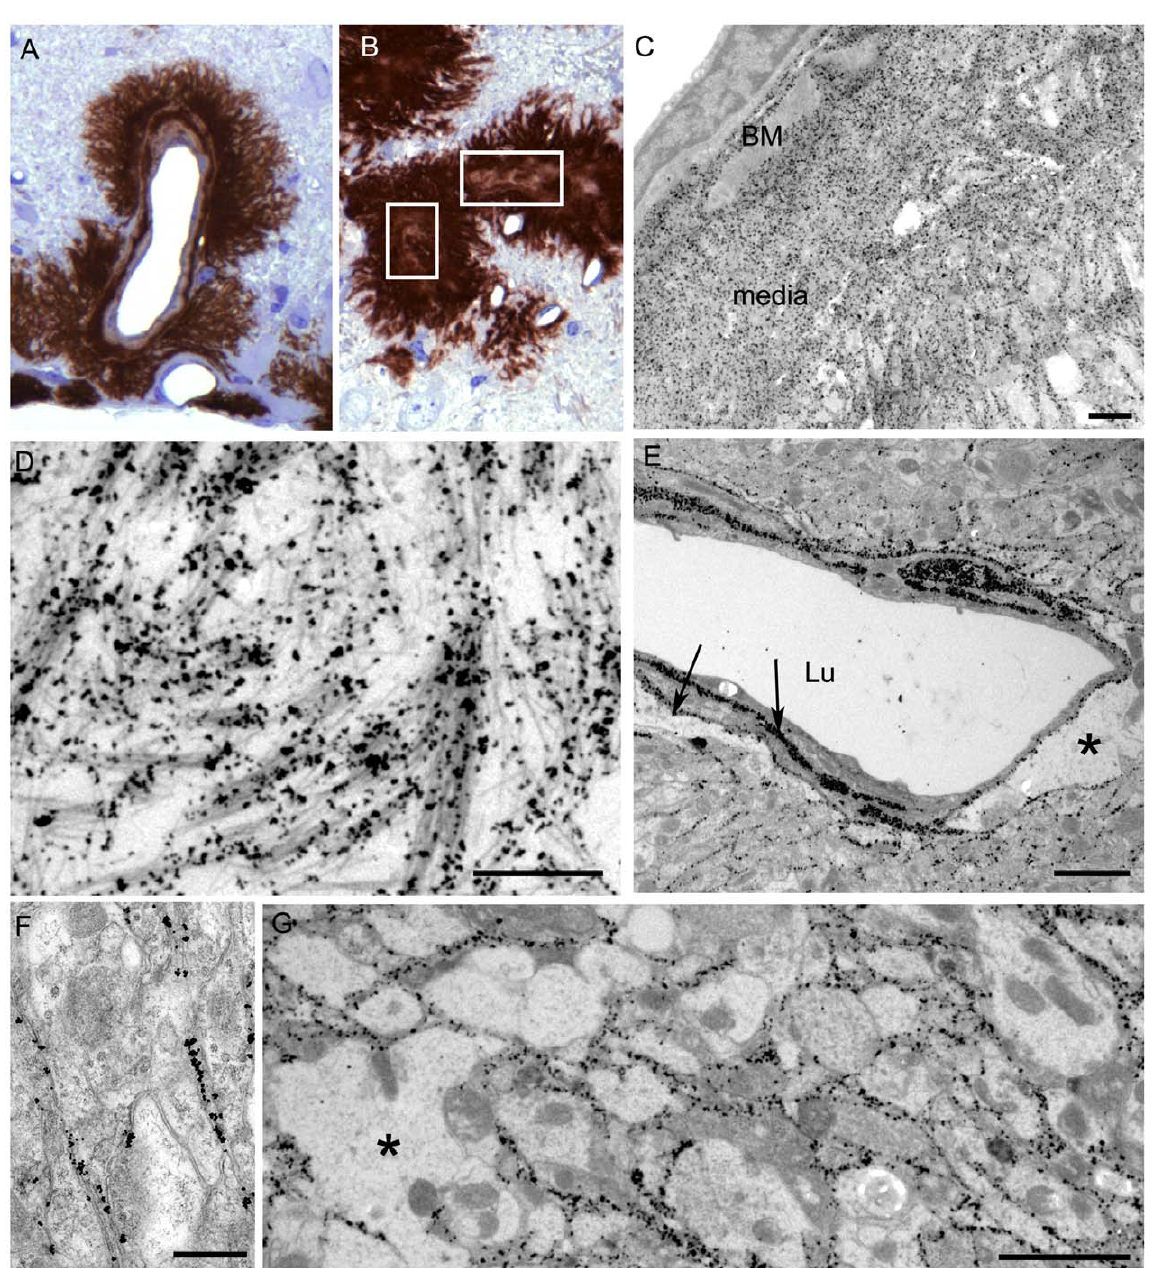
Figure 5. Immunological detection of PrPres in brain at both light and electron microscopic levels. The 22L scrapie-infected anchorless PrP tg44 + / + mouse shown was clinically positive at 377 dpi. (A–B) Light microscopy of 1 m m thick plastic-embedded tissue labelled with monoclonal antibody 1A8. (A) shows intravascular and perivascular PrPres. In (B), the marked vascular amyloid infiltration is associated with occlusion of the vascular lumen (boxes indicate occluded lumens of two vessels). When these vessels were visualised in the electron microscope the smooth muscle of the vascular media was totally replaced by amyloid and an amorphous electron dense material filled the lumen (not shown). (C–F) Electron microscopy. (C) Low power view of large PrPres amyloid plaque adjacent to a small artery. Vessel lumen is in upper left corner and an endothelial cell with a prominent nucleus is to the right of the lumen. Silver enhanced gold-labeled PrPres is seen within the basement membrane (BM) and within the heavy amyloid accumulation which partially replaces the smooth muscle media layer. Amyloid bundles radiate away from the vessel and through the neuropil at the bottom right. (D) A high magnification illustration of (C) showing PrPres labelling on small bundles of amyloid fibrils at the periphery of the plaque. (E) Marked PrPres accumulation at the endothelial and pericyte basement membranes (arrows) and extending into narrow extracellular spces between nearby neurites and perivascular glial processes. Asterix (*) shows area of astrocytic cytoplasmic swelling. Lu; lumen. (F) Neuropil of cerebrum showing immunogold label for PrPres present over the extracellular spaces between neurites bounded by pairs of adjacent plasmalemmae. No visible amyloid fibrils were visible and the spaces between cellular processes were regular and even. This non-fibrillar PrPres labelling which dissects between neurite and glial cell profiles may extend over large area of neuropil as shown in (G). Asterix (*) on left side shows enlarged glial process with loss of normal cytoplasmic organelles. Similar findings were observed in tg44 + / + , tg44 + / 2 and tg23 + / 2 mice. Tg23 + / + mice were not examined by electron microscopy. Scale bars: A and B, 20 m m; C and D, 1 m m; E and G, 2 m m; F, 500 nm.